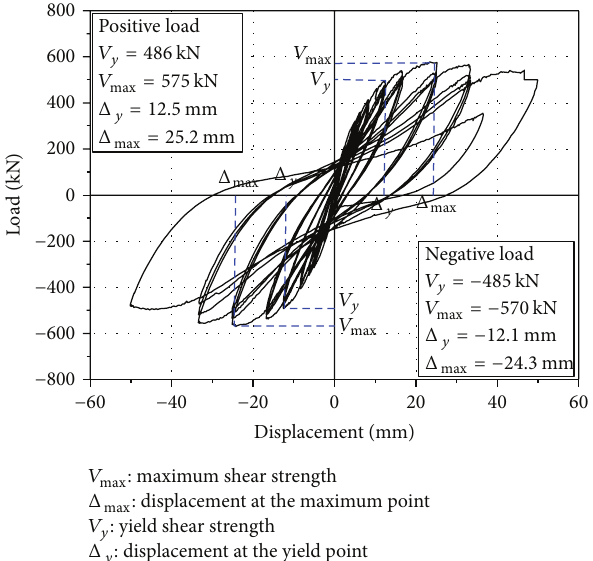
Figure 14: Lateral load-displacement curve for the CL-FK speci-